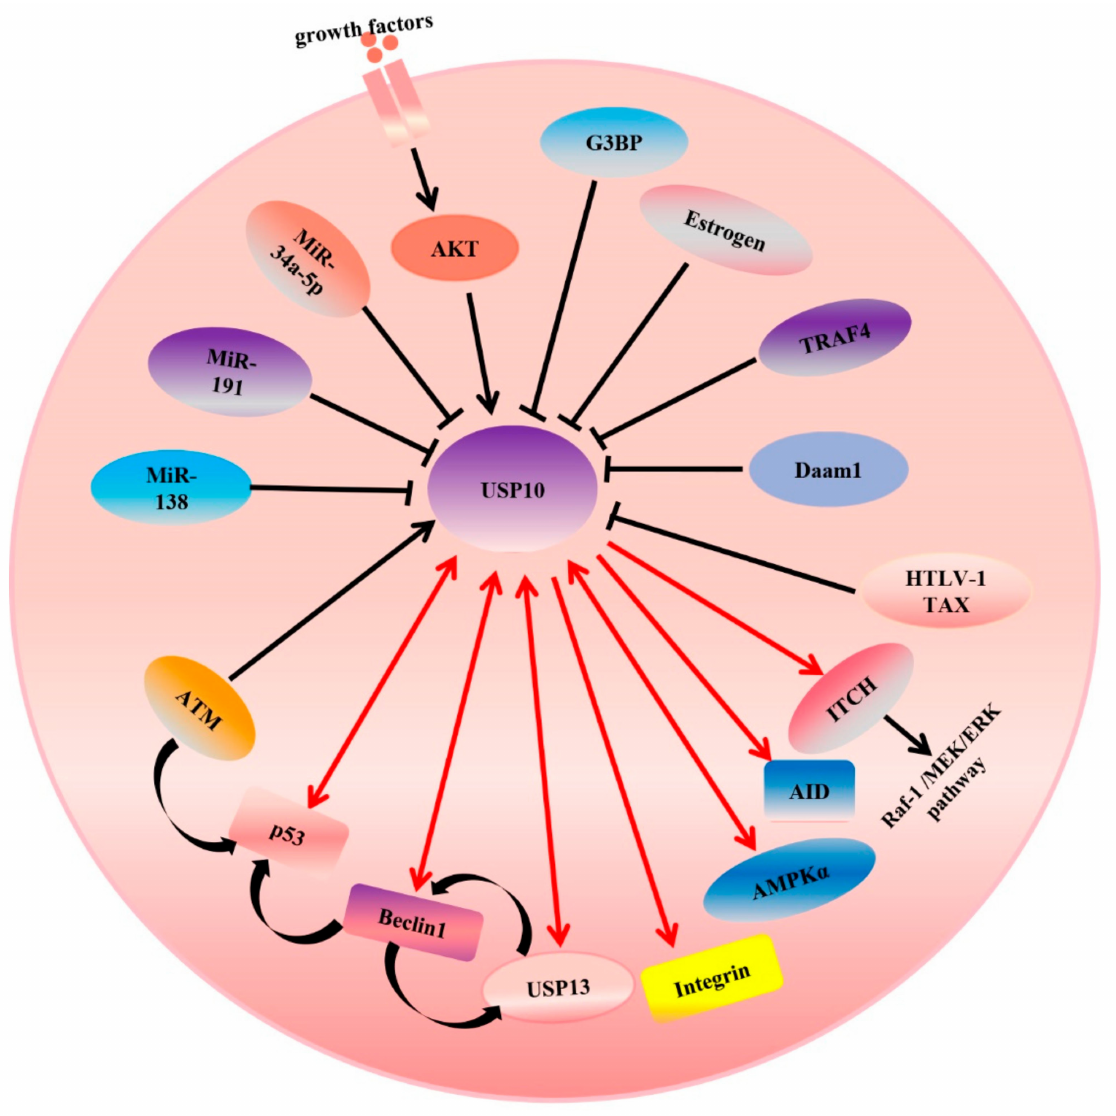
Figure 4. USP10 targets different signaling pathways in cancer